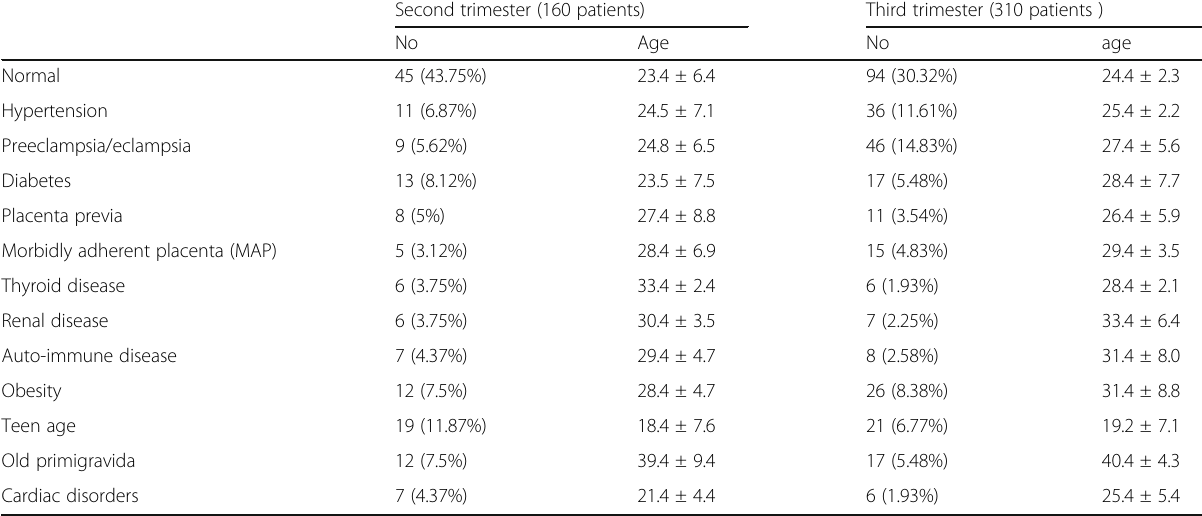
Table 1 Number and age of females with normal and high-risk